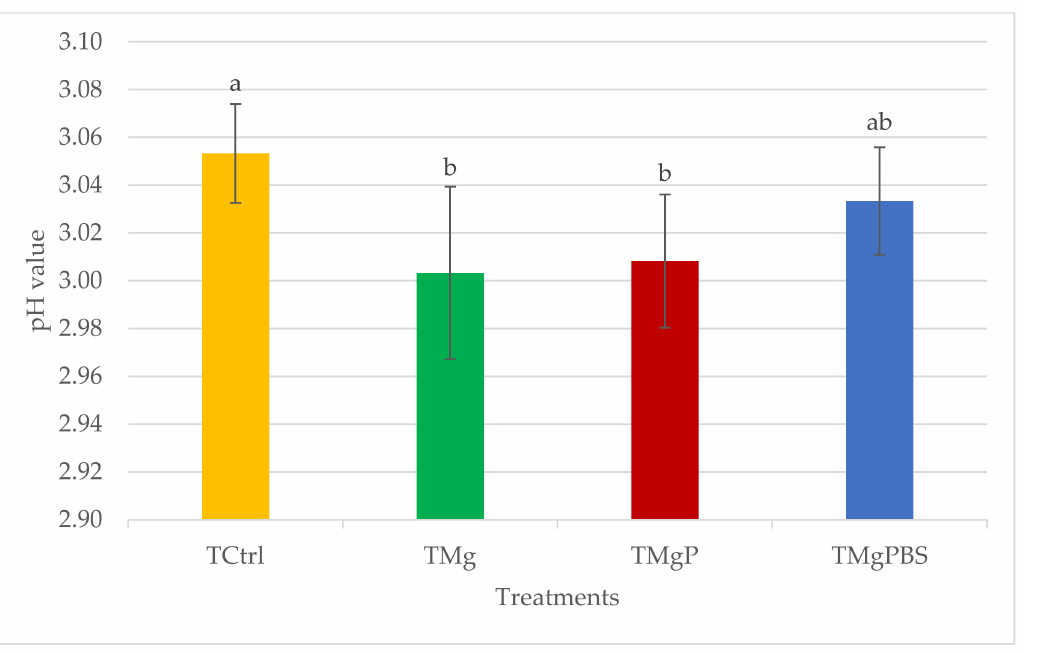
Figure 6. pH of must by treatment. (TCtrl—NPK, TMg—NPK + Agromag (6% MgO), TMgP—NPK + Agromag + Fosforo (30% P 2 O 5 ) i TMgPBS—NPK + Agromag + Fosforo + Bio Prot) Bars with